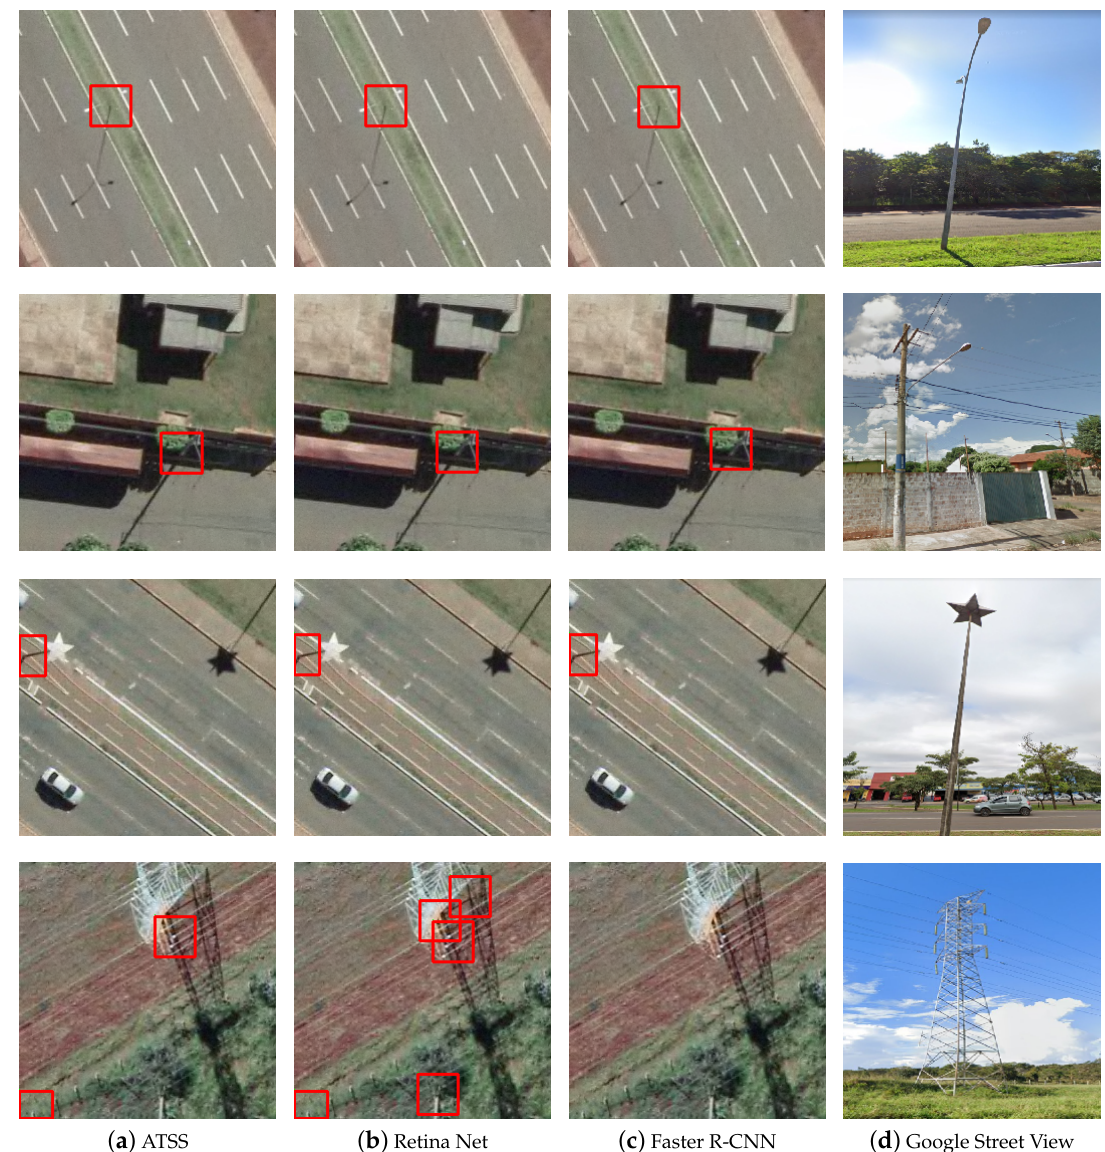
Figure 7. Examples of images with different models and shapes of poles: ( a ) ground-truth; ( b ) ATSS; ( c ) RetinaNet; and ( d ) Faster